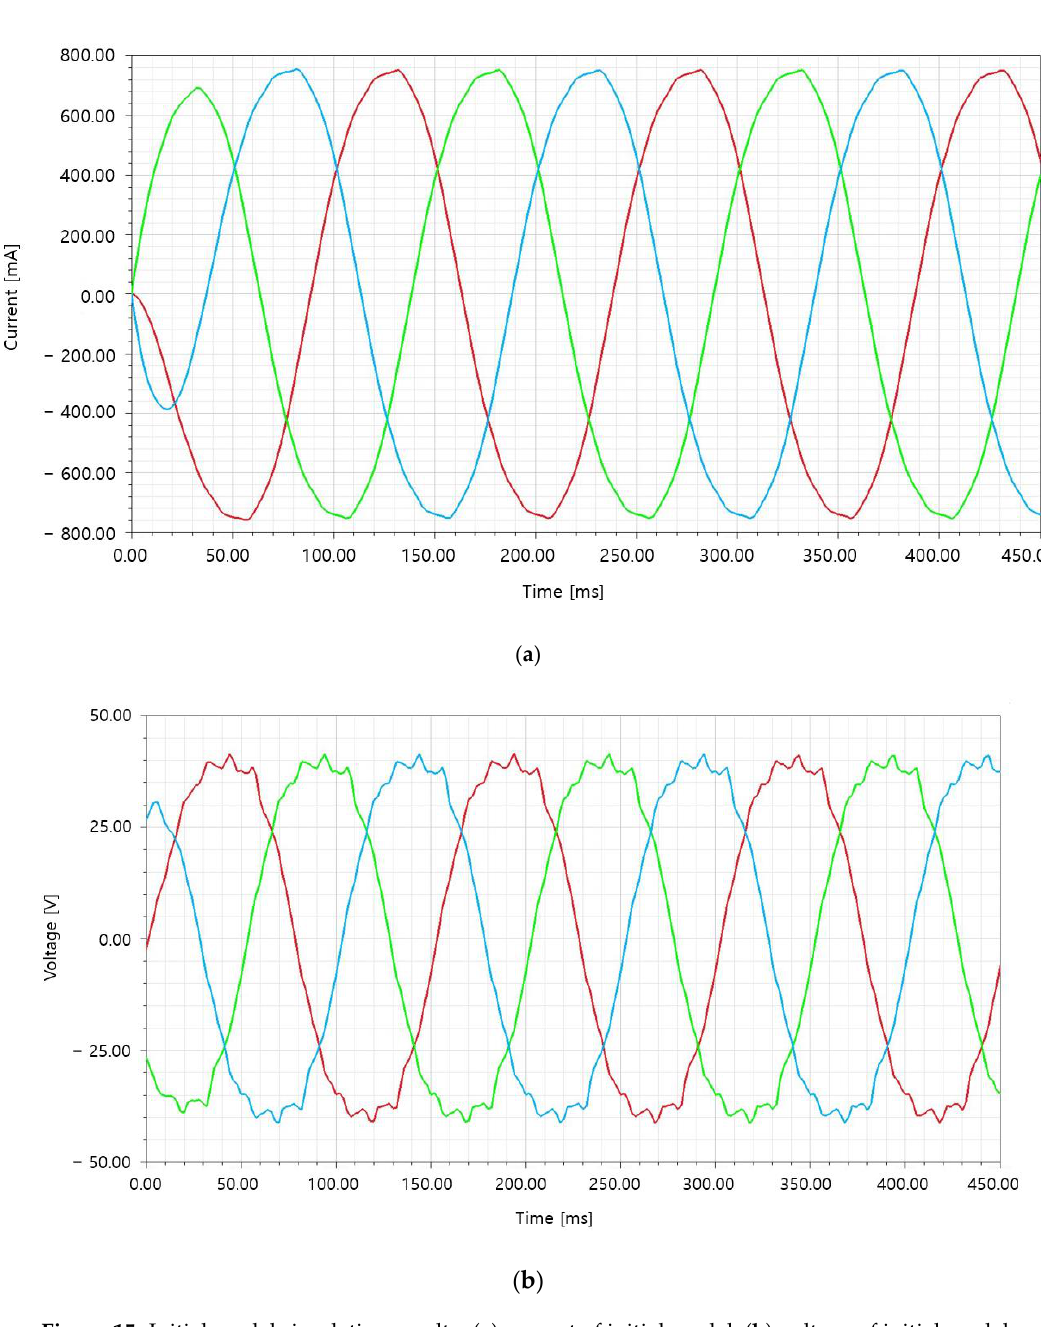
Figure 15. Initial model simulation results: ( a ) current of initial model; ( b ) voltage of initial model.